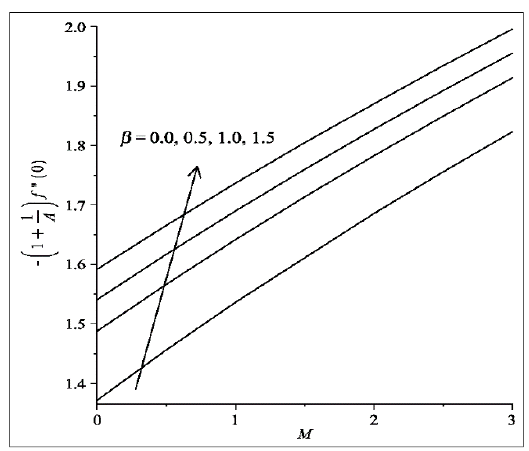
Figure 14. Various values of β on the skin friction coe ffi cient and M .